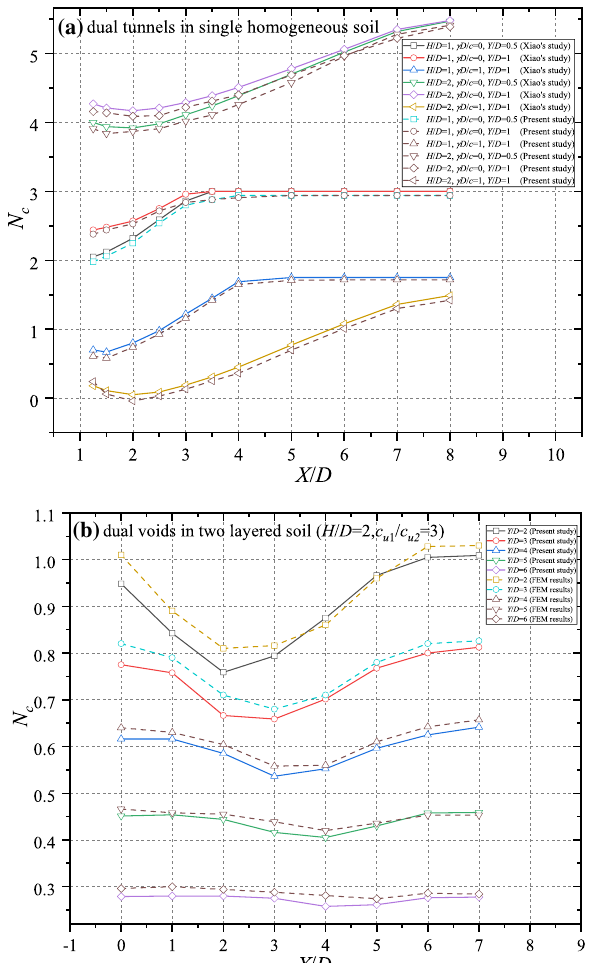
Figure 3. Comparison of N c − X / D curves for ( a ) dual tunnels in homogeneous soil; ( b ) dual tunnels in two layered